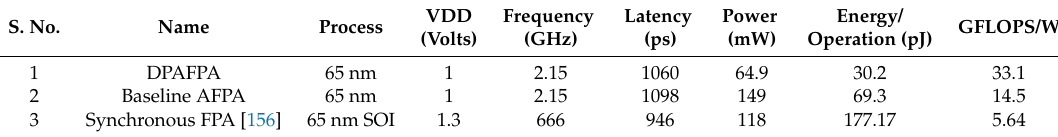
Table 1. Comparison of DPAFPA with baseline FPA and synchronous FPA